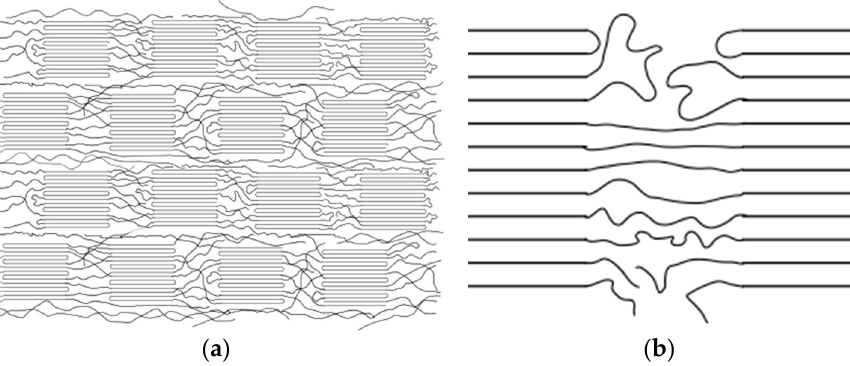
Figure 11. Scheme: ( a ) semicrystalline structure of polymer fi bers; ( b ) amorphous area of the fi ber.